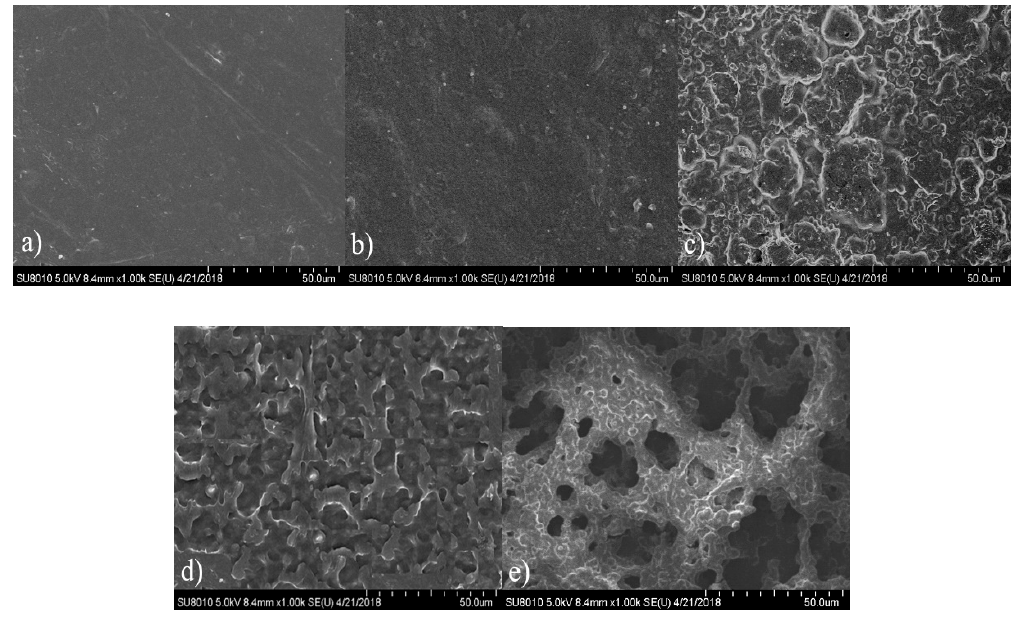
Figure 9. Surface morphologies of CPU-1.4 film in PBS (pH: 7.4) at 37 ± 0.1 °C after ( a ) 0; ( b ) 3; ( c ) 6; ( d ) 10; and ( e ) 12 months’ degradation.